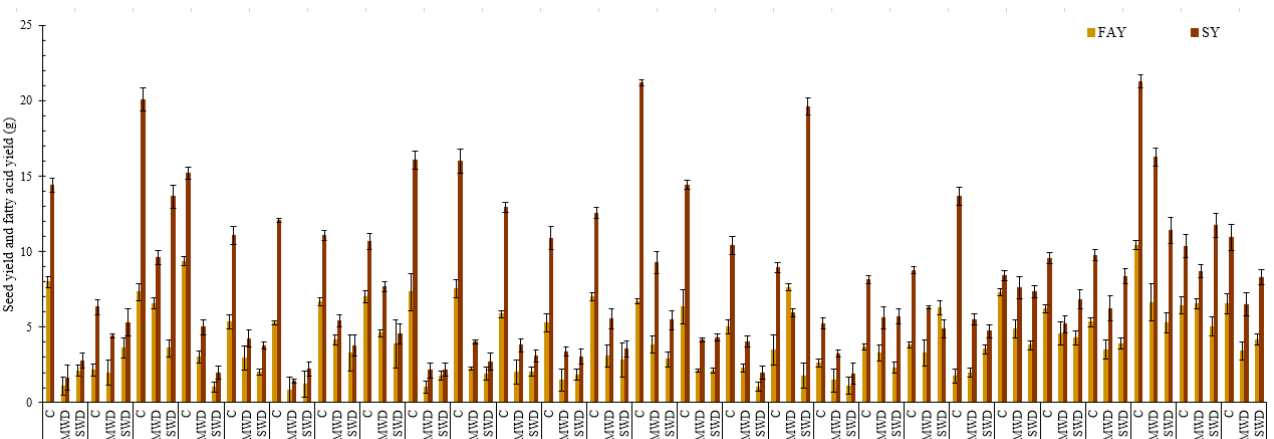
Figure 4. Water treatment (WT) × genotype interaction effect on seed yield (SY) and fatty acid yield (FAY). C: control; MWD: moderate water deficit; SWD: severe water deficit. L 1 –L 3 : three testers, G 1 –G 6 : 6 male parents; L 1 G 1 –L 2 G 6 : 12 single hybrids; and L 3 G 1 –L 3 G 6 : 6 three-way hybrids in a modified triple test cross.